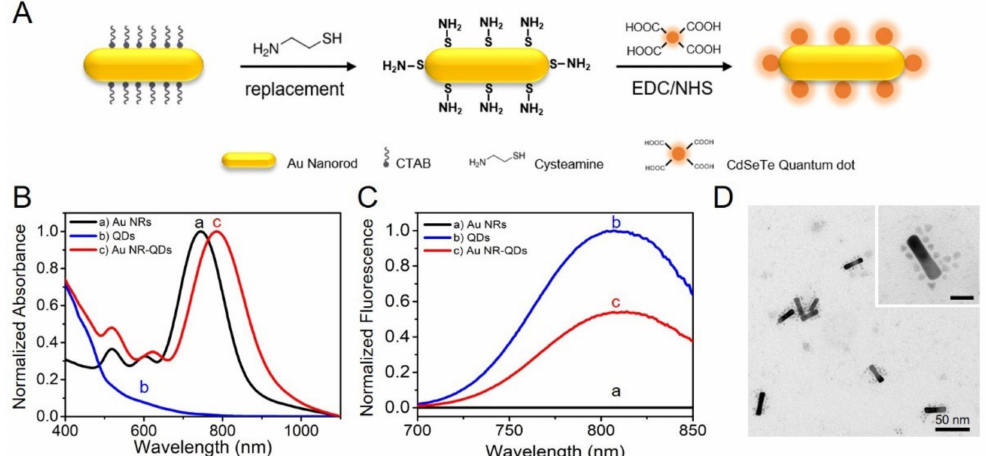
Figure 1. The fabrication and characterization of the plasmon-emitter hybrid nanostructures of Au NR-QDs assemblies. ( A ) The schematic illustration for the fabrication process of Au NR-QDs. ( B ) Normalized UV-vis absorption spectra of the Au NRs (a), QDs (b), and as-prepared Au NR-QDs (c). ( C ) Normalized fluorescence spectra of Au NRs (a), QDs (b), and Au NR-QDs (c) in the same process of ( B ), where the maximum fluorescence intensity of QDs was regarded as 1.0. ( D ) Transmission